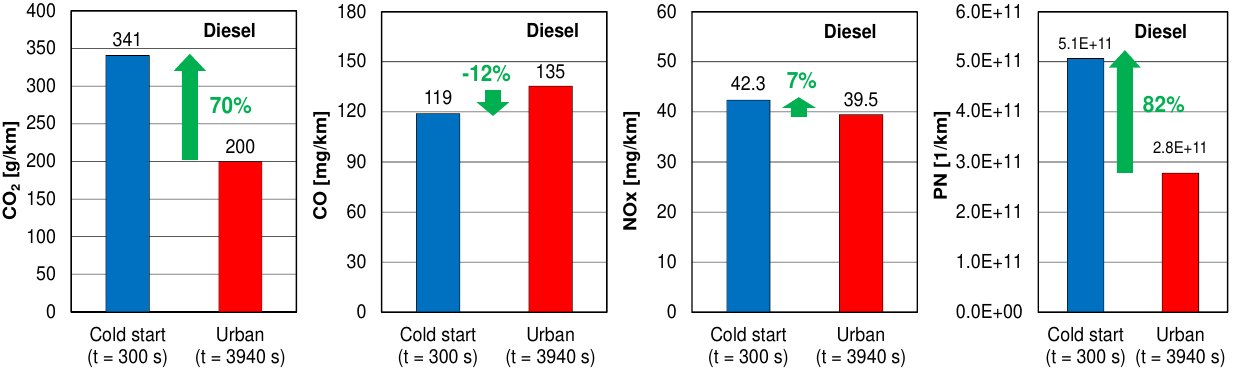
Fig. 13. Road emissions of carbon dioxide, carbon monoxide, nitrogen oxides and particles number during cold start of diesel